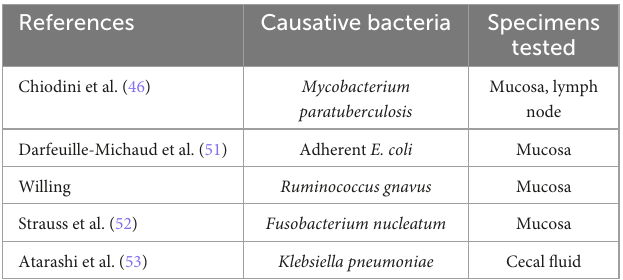
TABLE 5 Suspected causative bacteria for